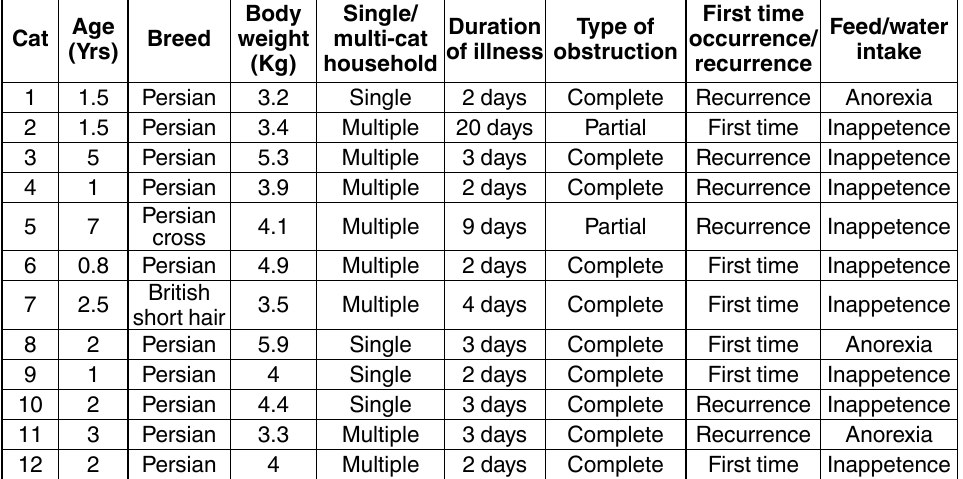
table1. Signalment and Anamnesis of the tom cats included in the study (n=12) age cat (Yrs)